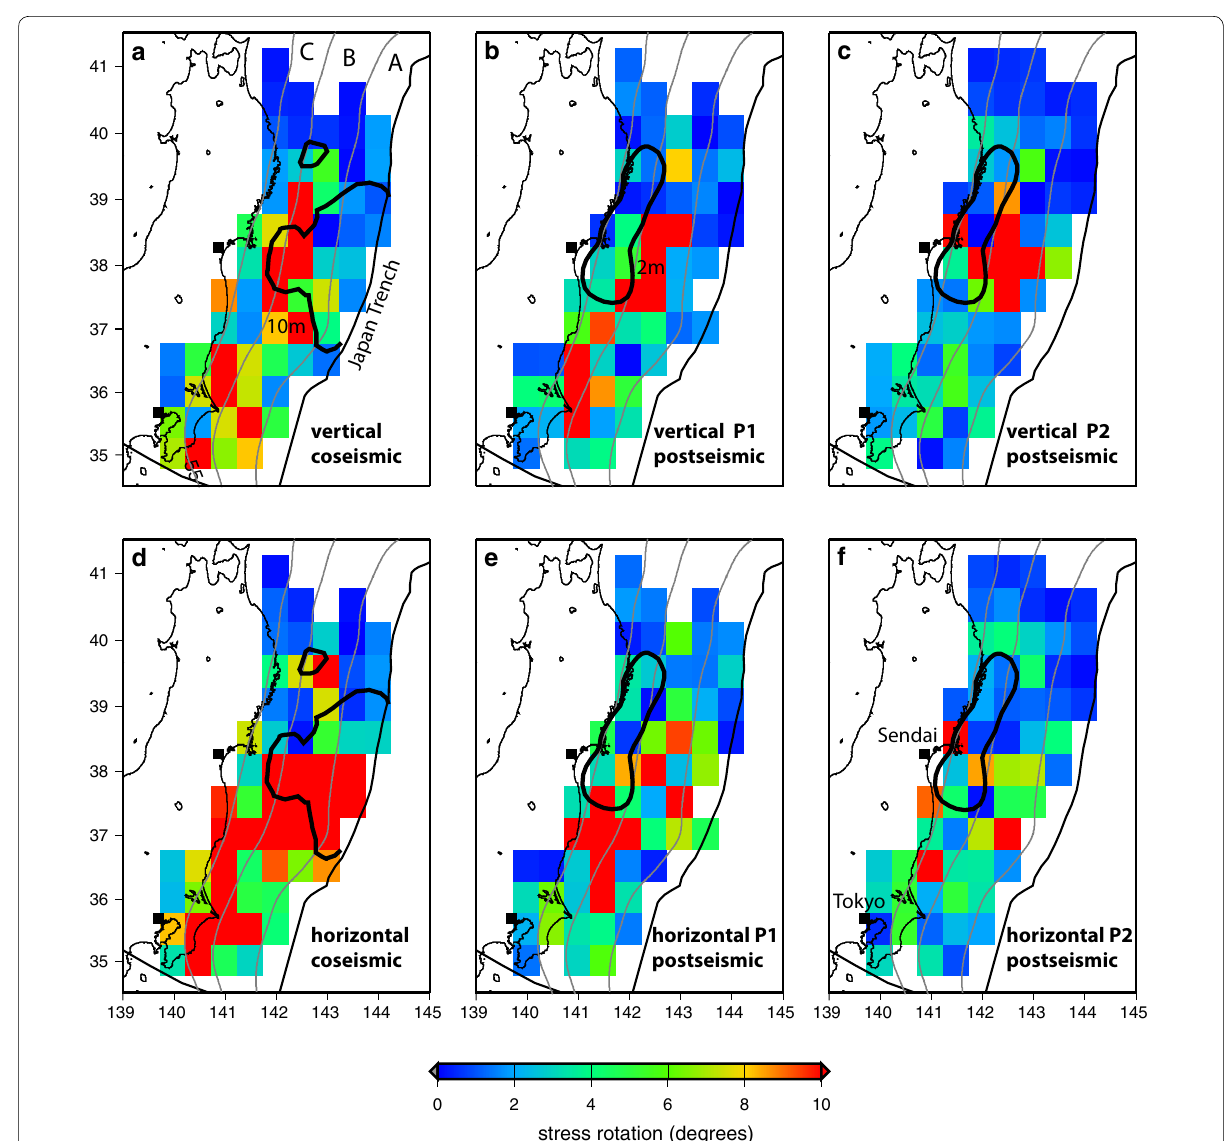
Fig. 1 Stress rotations following the 2011 M9.0 Tohoku-Oki earthquake. Shown are both the vertical rotation, i.e., the change in plunge of the σ 1 axis, and the horizontal rotation, i.e., the change in trend of the SHmax direction, for 0.5° 0.5° spatial bins. a Vertical coseismic rotation, the change × between the pre-mainshock (1997-2-16–2011-3-11) and first postmainshock (2011-3-11–2011-6-11) time periods. Thick black lines indicate the 10-m contour of the mainshock slip model of Minson et al. (2014), b vertical postseismic rotation P1, between the first and second (2011-6-11–2012-6-11) postmainshock time periods. Thick black lines indicate the 2-m contour of the postseismic slip model of Ozawa et al. (2011), c vertical postseismic rotation P2, between the second and third (2012-6-11–2016-9-17) postmainshock time periods, d horizontal coseismic rotation, e horizontal post- seismic rotation P1, f horizontal postseismic rotation